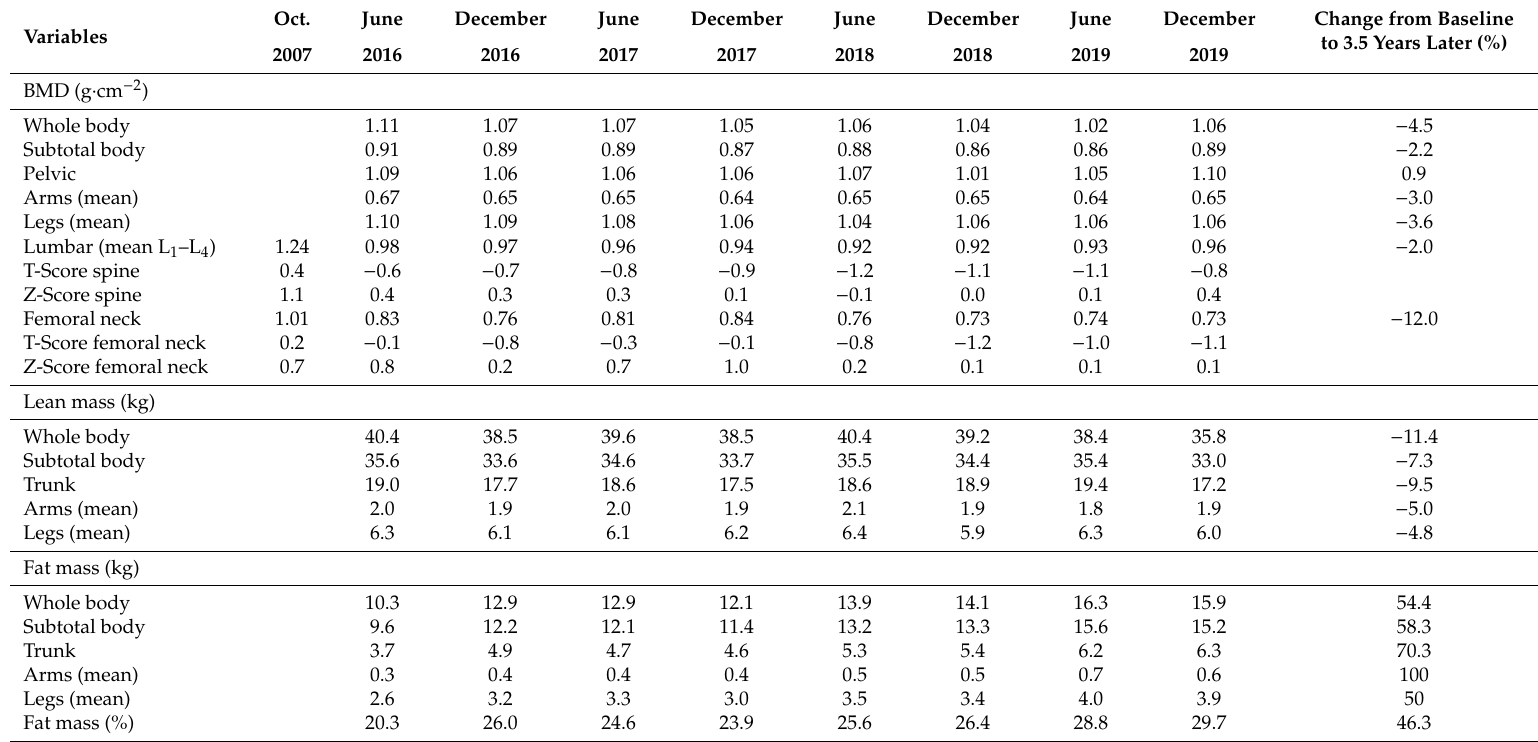
Table 4. Results of body